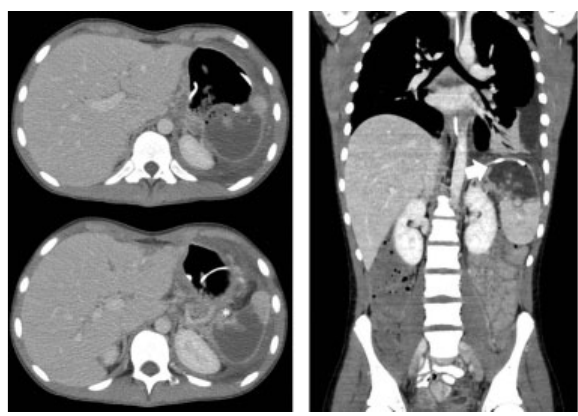
Fig. 1 CTscan images demonstrating gastrosplenic fi stula. ( (cid:3) ) shows fi stulous communication between stomach and spleen. Arrowhead represents coiled feeding tube within the capsule of the spleen. CT, computed tomography.